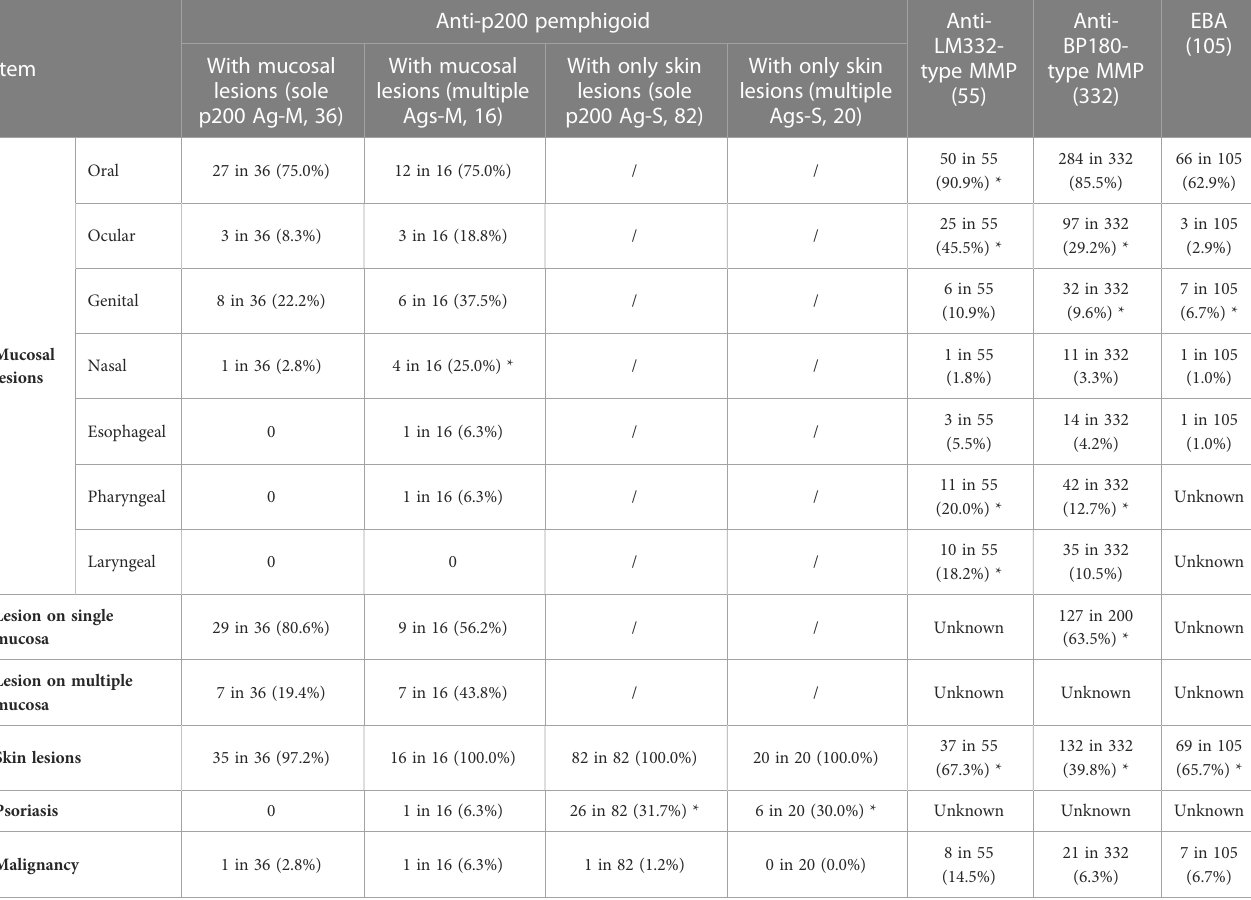
TABLE 4 Comparison of clinical features between anti-p200 pemphigoid with mucosal lesions and other AIBD